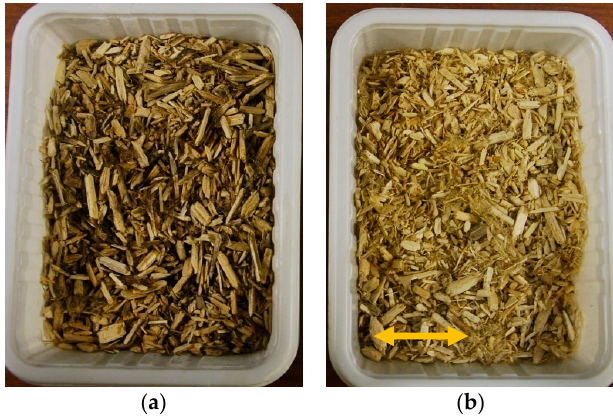
Figure 1. Hemp shives with average length of ( a ) 15 mm and ( b ) 6 mm (yellow unit 20 mm).